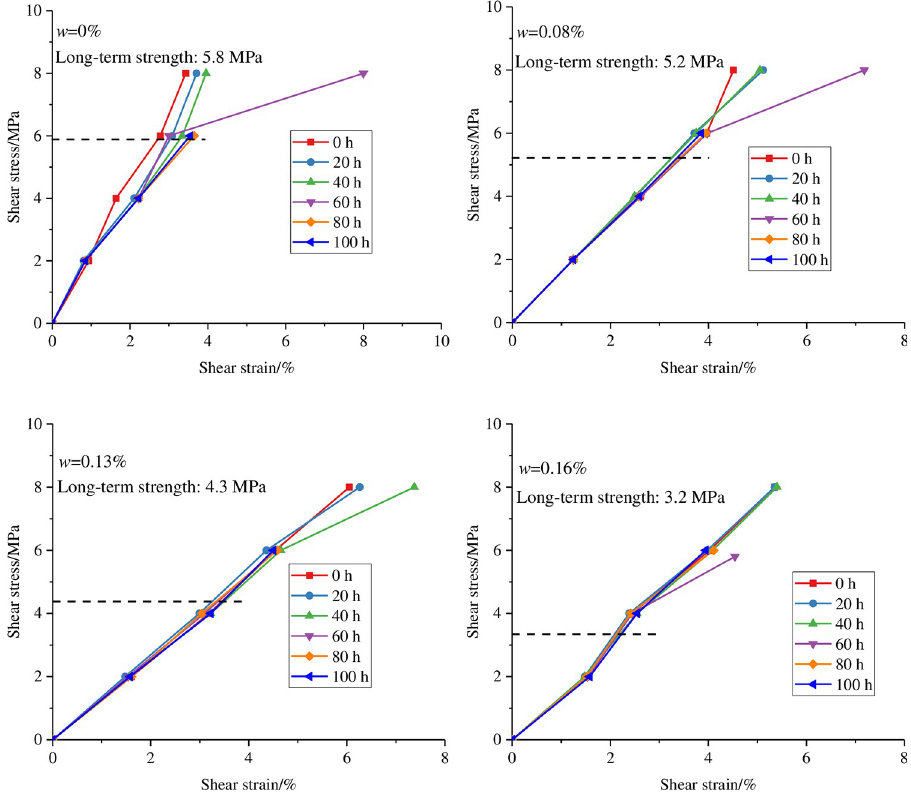
Fig 6. Isochronal stress–strain curves of the anchorage rock mass under different water